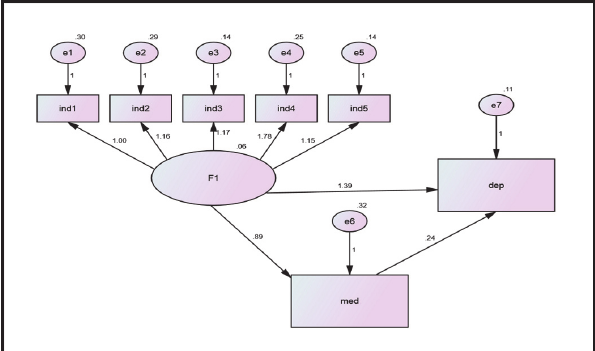
Fig. 2. Results of Testing the Fourth